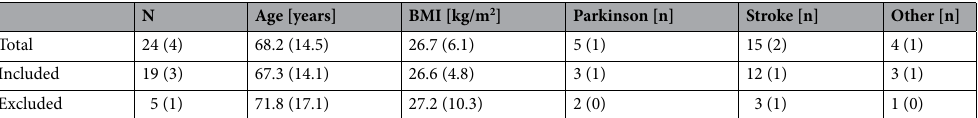
Table 1. demographic information from study 1 participants. The data is segregated into three rows: one with the demographic information over all study 1 participants (Total), one with the demographic information of participants who passed the data quality assessment (Included in analysis), and one with the demographic information of excluded participants (Excluded from analysis). The columns “n” (participant count), “Parkinson”, “Stroke”, “Other” contain the number of participants with diagnosed condition, with the number of females in parenthesis. The columns “Age”, “BMI” (body mass index), specify the mean value, with its standard deviation in parenthesis.